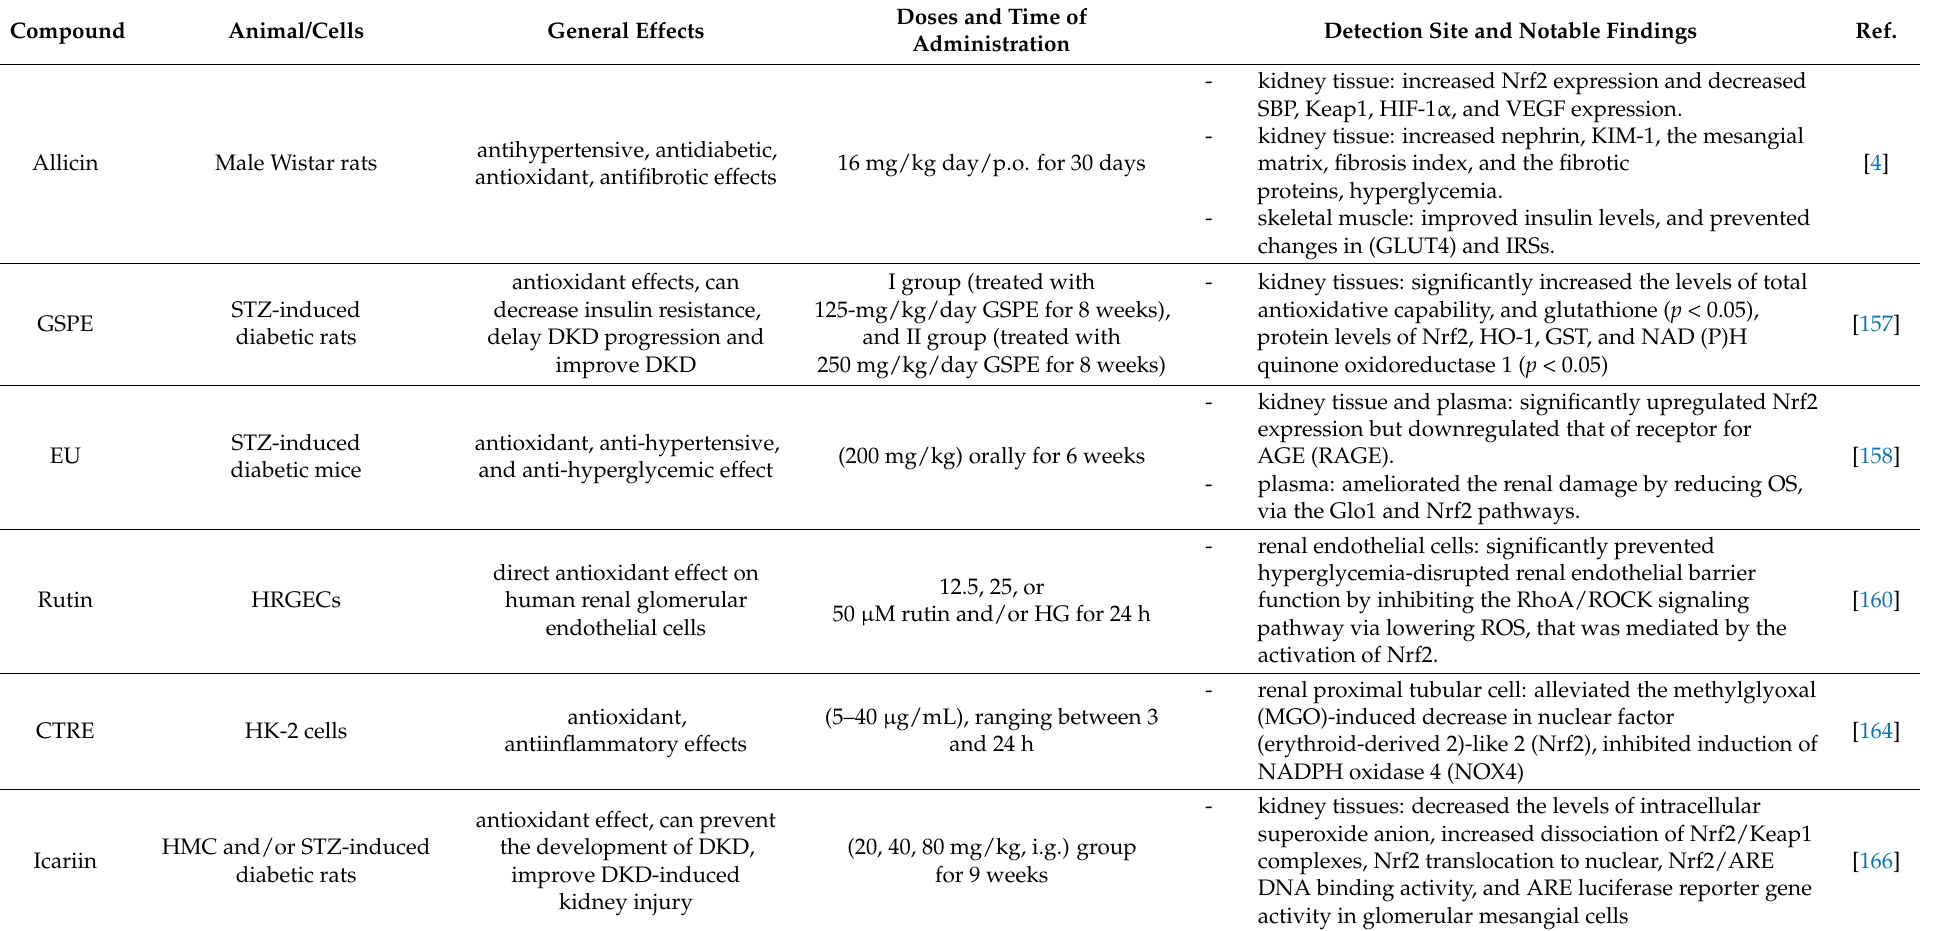
Table 2. Novel compounds with therapeutic potential in DKD via modulation of the NRF2/KEAP1/ARE pathway. Compound Ref.